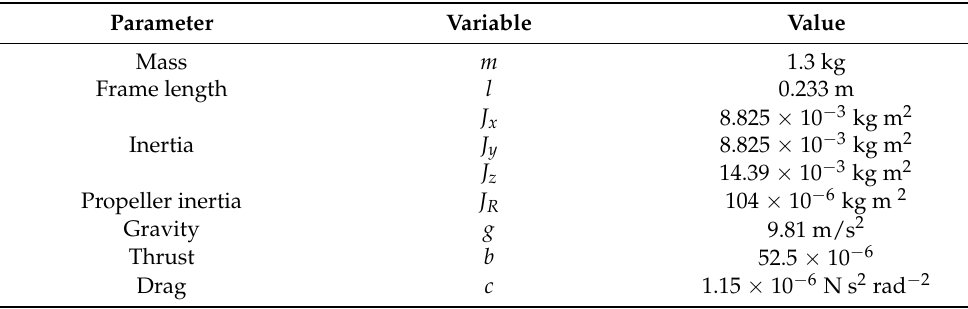
Table 2. Coefficients and variables of the